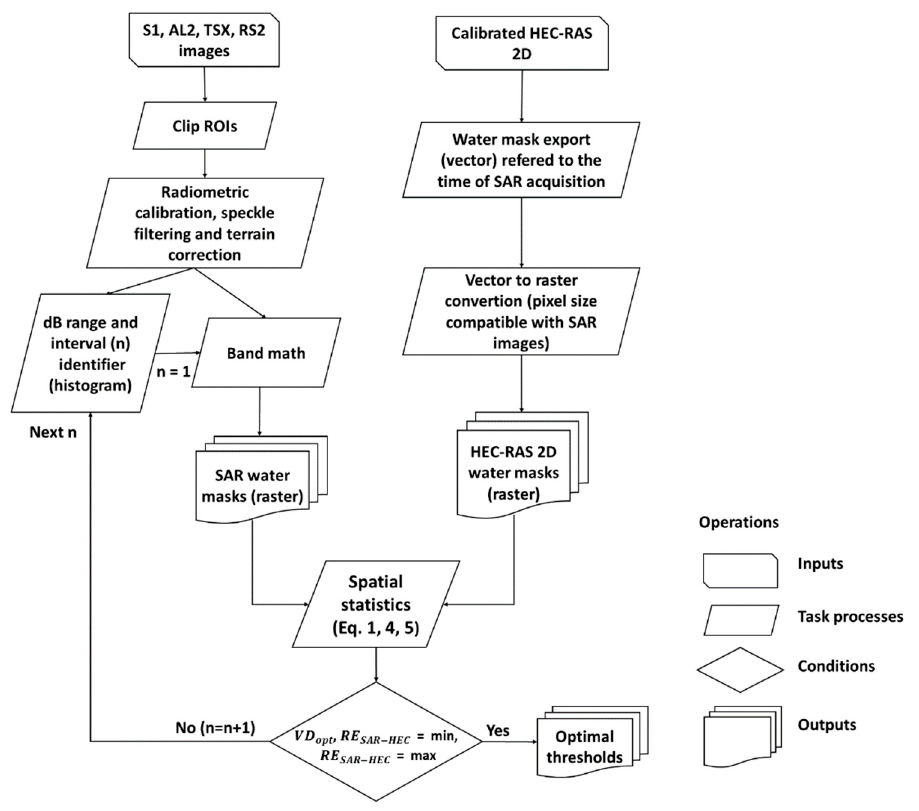
Figure 5. Schematic of the HST algorithm to obtain optimal thresholds. S1, AL2, TSX and RS2 stand for Sentinel-1, ALOS2, TerraSAR-X and RadarSAT-2, respectively. ROIs are regions of interest. Equations (1), (4), (5) are the equations defined in the above. n is the number of threshold adjustments defined in the Equation (1). The VD opt , RE SAR − HEC and P SAR & HEC are defined in the Equations (1), (4) and